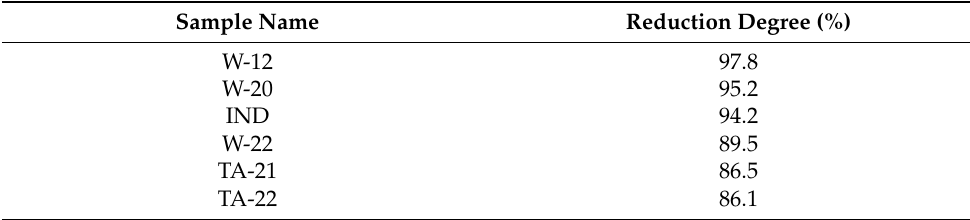
Figure 3. TPR profile of precursors. Table 3. Reduction degree of precursors obtained in the reduction process performed up to 1000 °C with heating rate of 10°/min.